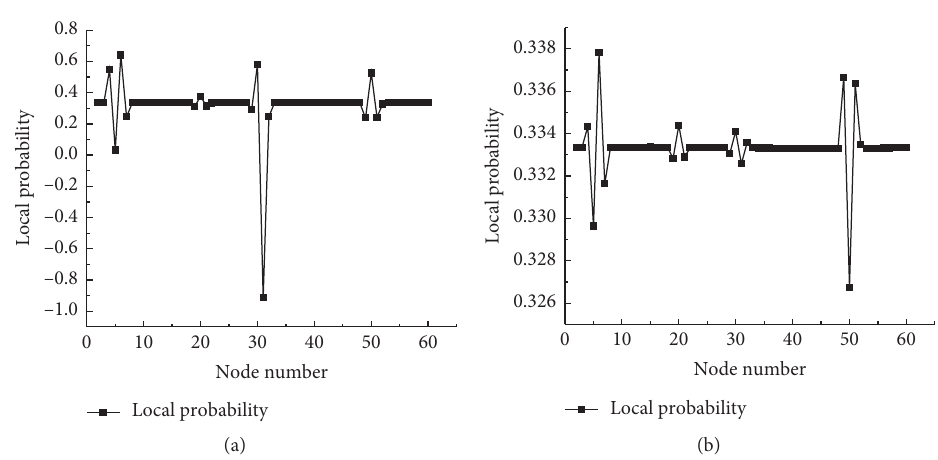
Figure 4: Local probability of modal curvature. (a) Original local probability. (b) Modified local probability.